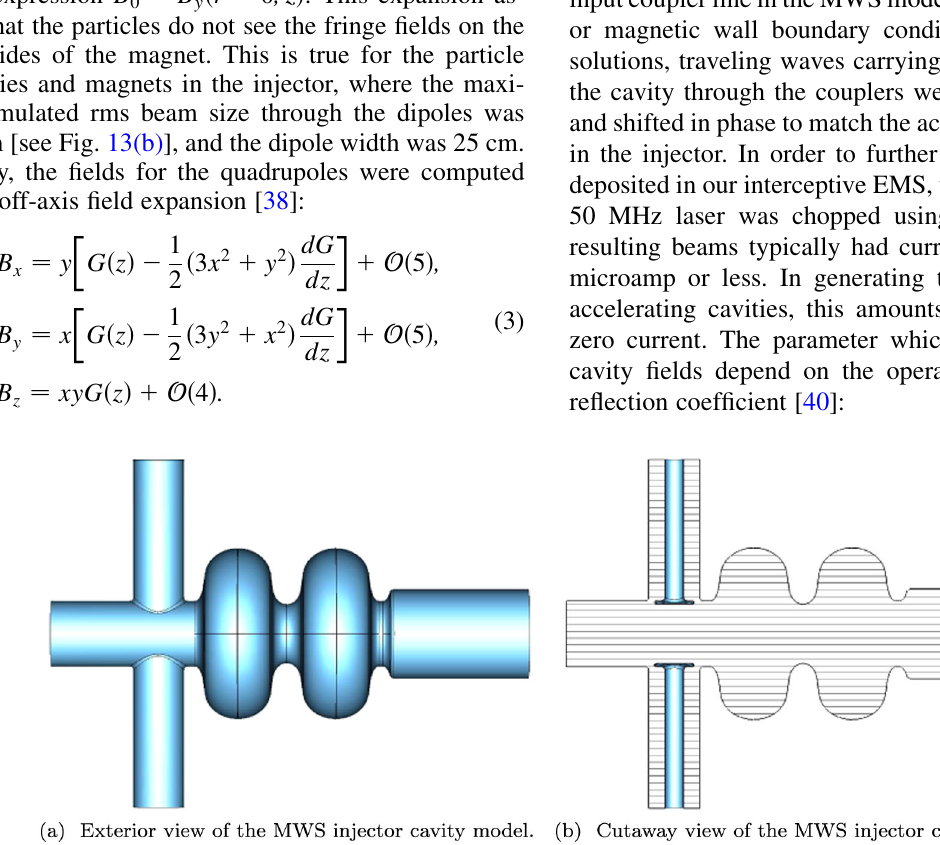
FIG. 4. (a) The MICROWAVE STUDIO model of the ERL injector cavity: (a) the cavity and coupler exterior, (b) cutaway view of the same model showing the inner coupler